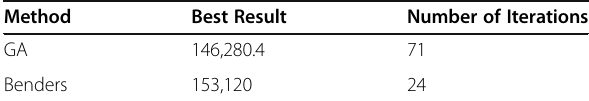
Table 4 Comparison